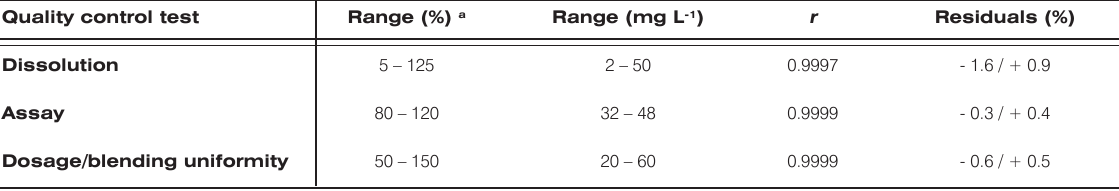
Table 1. Linearity of the proposed HPLC